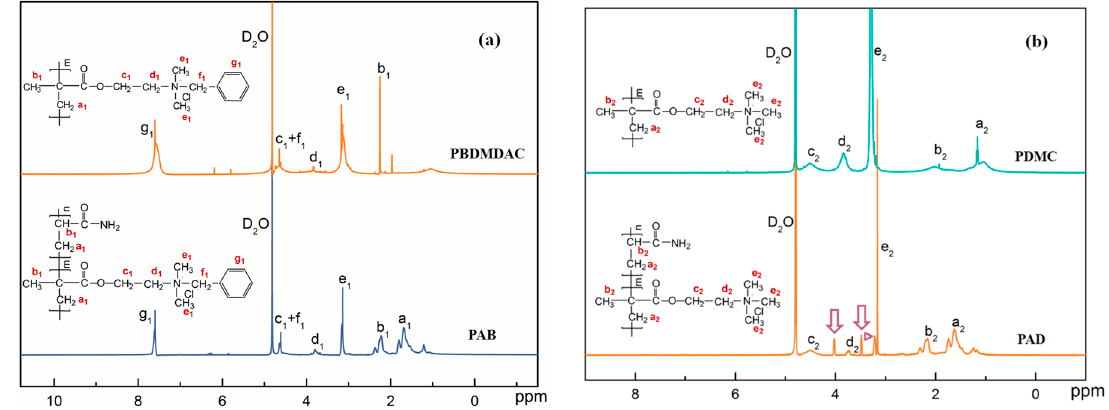
Figure 5. 1 H NMR spectra of the polymers: ( a ) poly(benzyl dimethyl 2-(methacryloyloxy)ethyl ammonium chloride) (PBDMDAC) and PAB; ( b ) poly(methacrylatoethyl trimethyl ammonium chloride) (PDMC) and PAD.